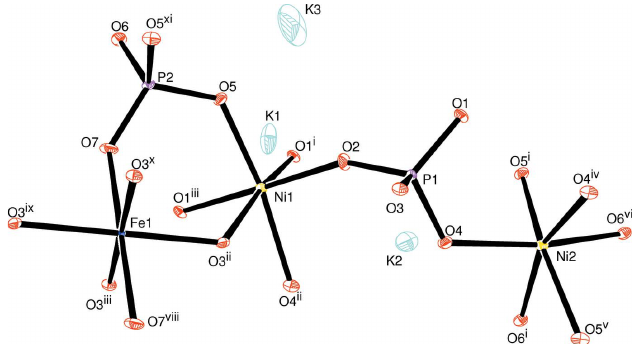
Figure 1 Molecular structure of the title compound with the atom-labelling scheme. Displacement ellipsoids are drawn at the 50% probability level. Symmetry codes: (i) (cid:3) x + 1 z (cid:3) 1; (iv) (cid:3) x + 1, y , (cid:3) z + 2; (v) x + 1 (vii) (cid:3) x + 1, (cid:3) y + 1, (cid:3) z ; (viii) x , (cid:3) y + 1, z (cid:3) 1; (ix) (cid:3) x + 1, (cid:3) y + 1, (cid:3) z + 1; ( x ) x , (cid:3) y + 1, z ; (xi) x , y , z + 1; (xii) (cid:3) x + 1 (cid:3) z ; (xiv) x , (cid:3) y + 2, z